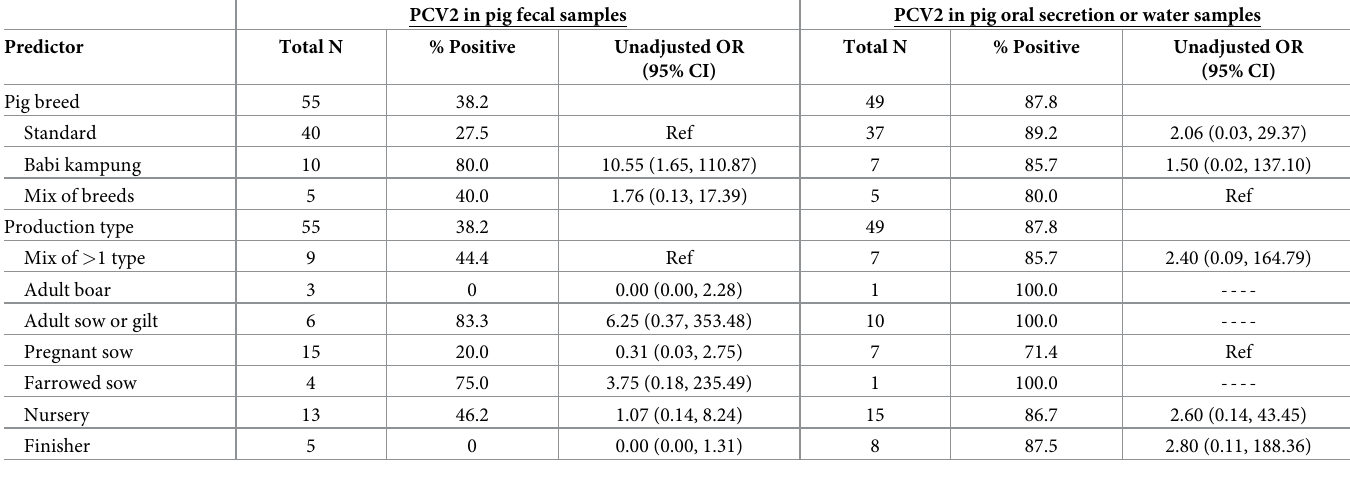
Table 3. Unadjusted odds ratios for risk factors associated with PCV2 molecular positivity of 55 pig fecal samples and 49 pig oral secretions or water samples col- lected from 11 pig farms in Sibu, Sarawak, Malaysia in July